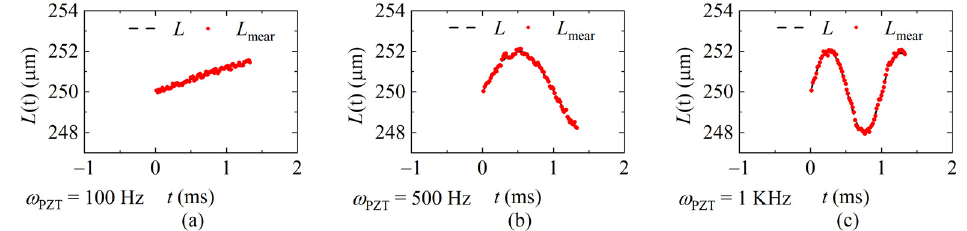
Figure 14. Measured values of different signal frequencies at 60 KHz sweeping rate. ( a ) ω PZT = 100 Hz ( v max = 0.001 m/s); ( b ) ω PZT = 500 Hz ( v max = 0.006 m/s); ( c ) ω PZT = 1 KHz ( v max = 0.01 m/s).